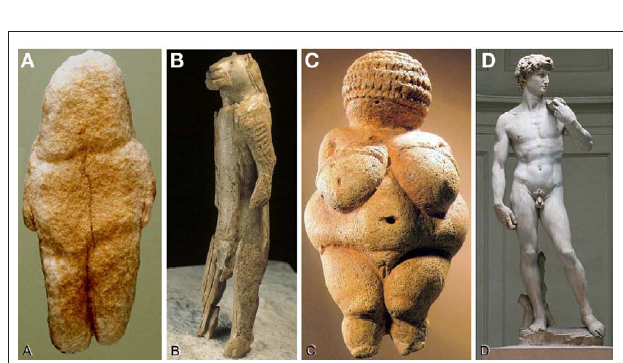
Figure 6 | Development of artistic creativity. Photographs of the Venus of Tan-Tan [6 cm in height, Morocco (A) , the lionman of Hohlenstein–Stadel [29.6 cm, Germany (B) , the Venus of Willendorf [11.1 cm, Austria (C) , and David of Michelangelo [517 cm, created from a single block of marble between the years 1501 and 1504 (D) . Taken from